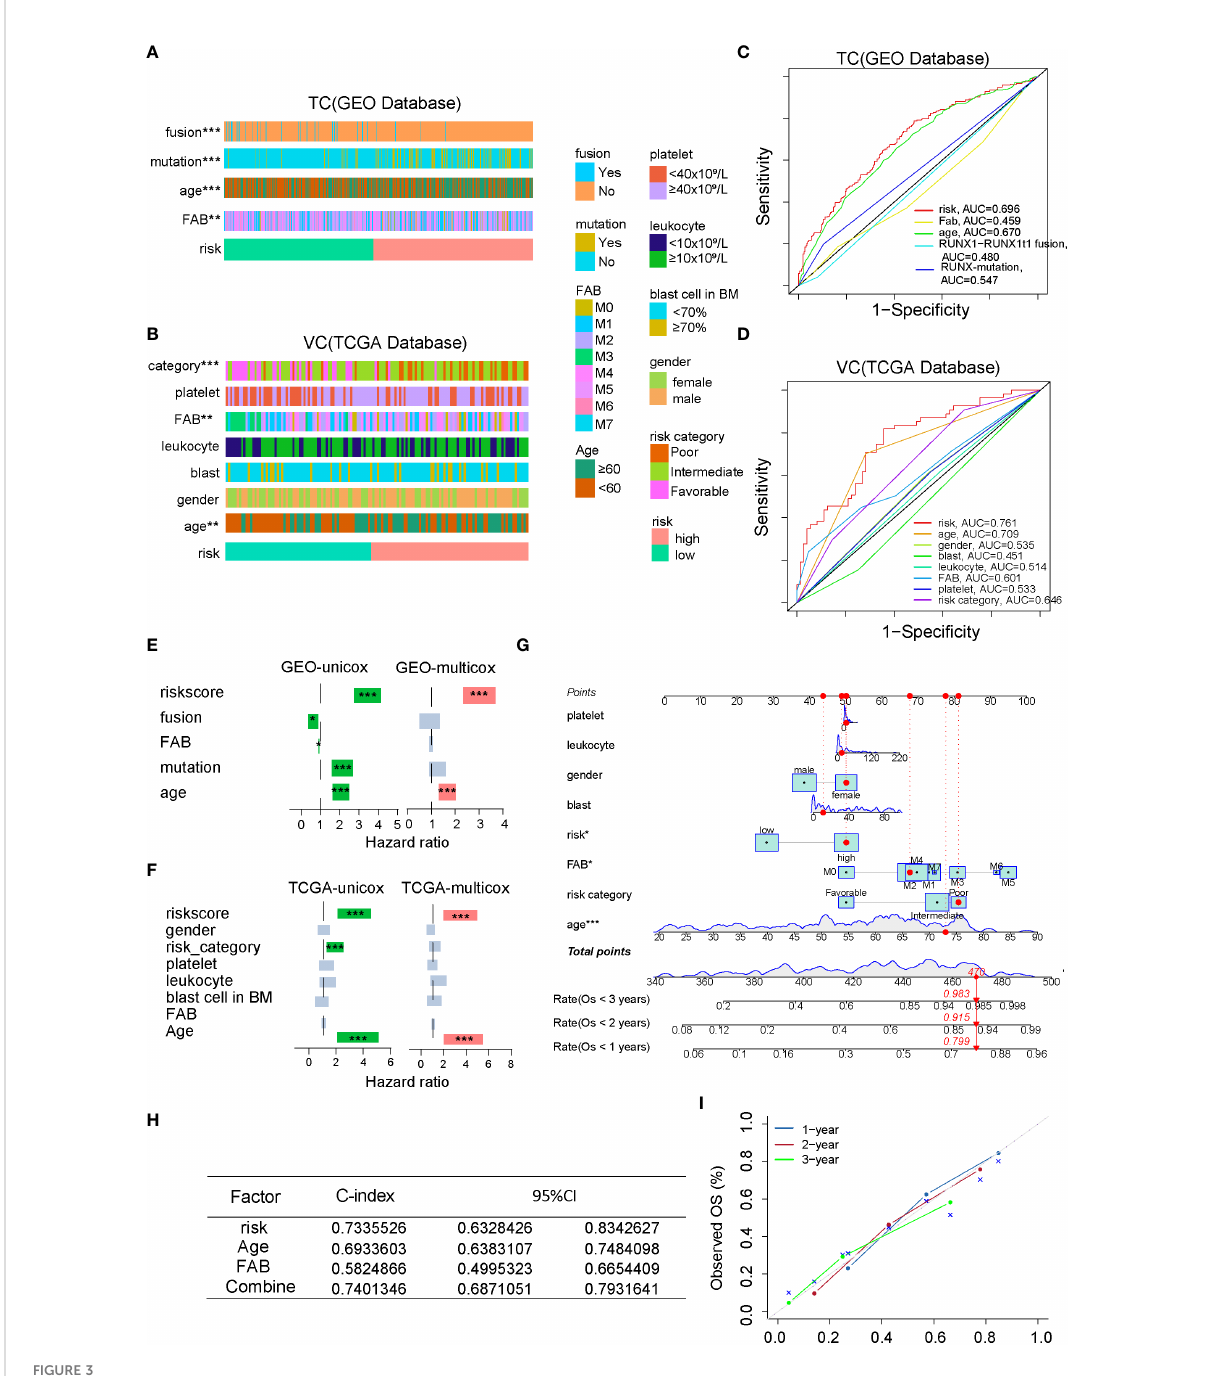
FIGURE 3 Combining the clinicopathological characteristics with the FAM formula optimizes the predictive capacity of the nomogram. (A, B) A strap plot summarized various clinicopathological features and FAM-related risk score, and the correlation between clinical features and the FAM risk score was analyzed by chisq.test. *p < 0.05,**p < 0.01, ***p < 0.001. (C, D) Evaluation of the prognostic prediction accuracy via the area under the time-dependent receiver operating characteristic (ROC) curve (AUC). (E, F) Stand-alone prognostic ability of the FAM formula or clinical features in the TC and VC. (G) Nomogram plot, based on the risk score and other clinicopathological patient pro fi les in the VC. (H) The consistency index (C-index) of the nomogram. (I) The calibration curve of the